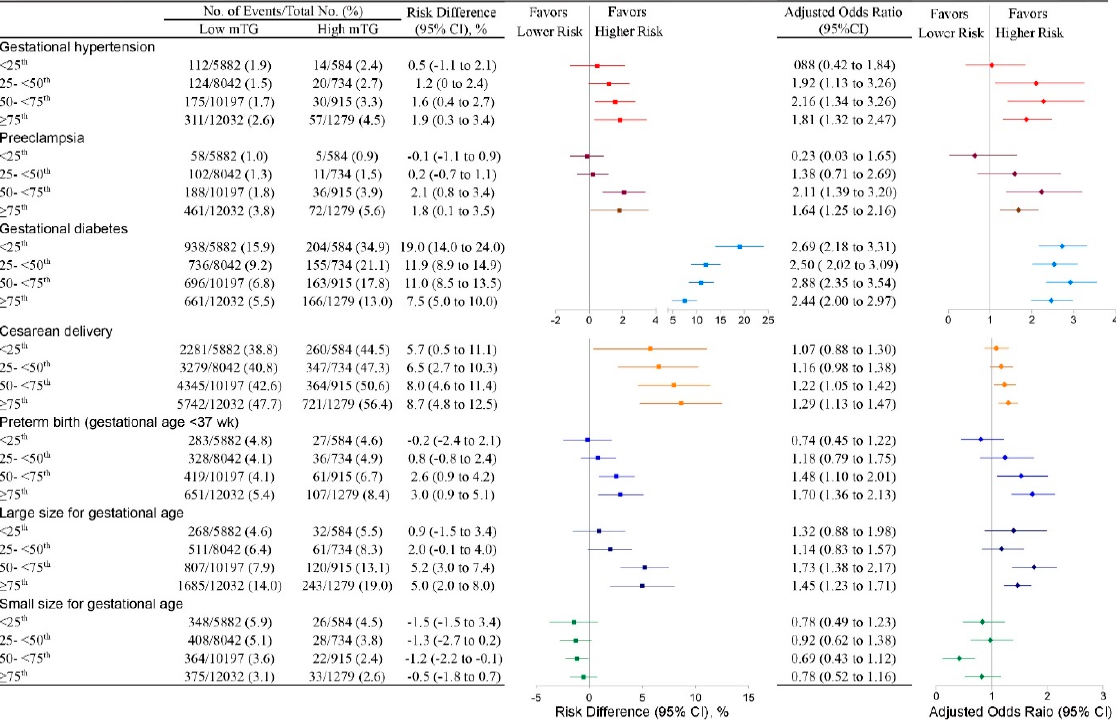
Figure 3. Association of maternal TG levels with adverse pregnancy outcomes among normal BMI women stratified by gestational weight gain. Absolute risk differences were calculated as the difference between the risks of high mTG and low mTG groups in each category of gestational weight gain (GWG). Adjusted odds ratios were shown for the association of mTG with adverse pregnancy outcomes and all analyses were adjusted for age, height, education, parity, place of birth, and timing of the blood draw during gestation. The reference group was women with low mTG in each outcome and each GWG category. GWG categories of Normal BMI women were stratified by the threshold of 3rd, 10th, 25th, 50th, 75th, 90th, and 97th percentile based on delivery gestational age. In accordance with the INTERGROWTH-21st Project, subgroups of <3rd, 3–10th, 10–25th were combined as <25th subgroup, and subgroups of 75–90th, 90–97th, ≥ 97th were combined as ≥ 75th subgroup to reduce the bias caused by fewer samples. For each outcome, the total number of women in the studies represented by the sample size assessed the outcomes. Risk differences, adjusted odds ratios, and each corresponding 95% CIs were calculated from the results of multivariable models and adjusted for baseline risk